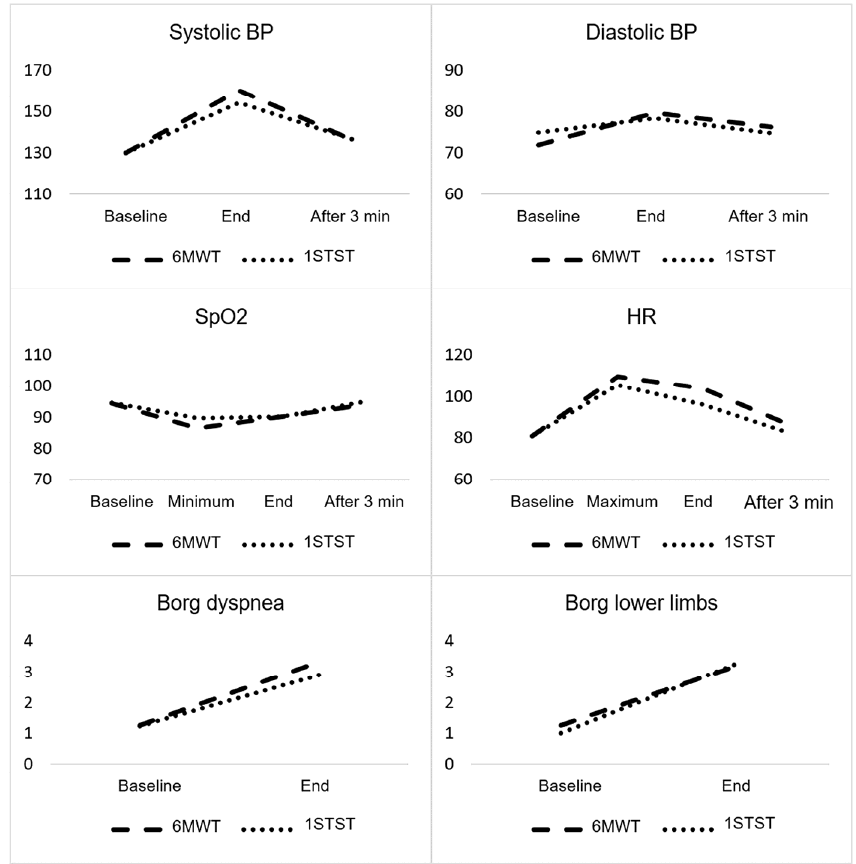
Figure 2. Evolution of cardiorespiratory parameters, Borg dyspnea, and lower limb fatigue during the 6MWT and the 1STST. (1STST = 1-min sit-to-stand test; 6MWT = 6-min walking test; sBP = systolic blood pressure; dBP = diastolic blood pressure; HR = heart rate; SpO 2 = oxygen saturation). Table 3. Agreement on cardiorespiratory parameters between 1STST and 6MWT evaluated by intra- class correlation coefficient (ICC). (1STST = 1-min sit-to-stand test; 6MWT = 6-min walking test; sBP = systolic blood pressure; dBP = diastolic blood pressure; HR = heart rate; SpO 2 = oxygen saturation). Variable Baseline Minimum Maximum End After 3 min sBP 0.780